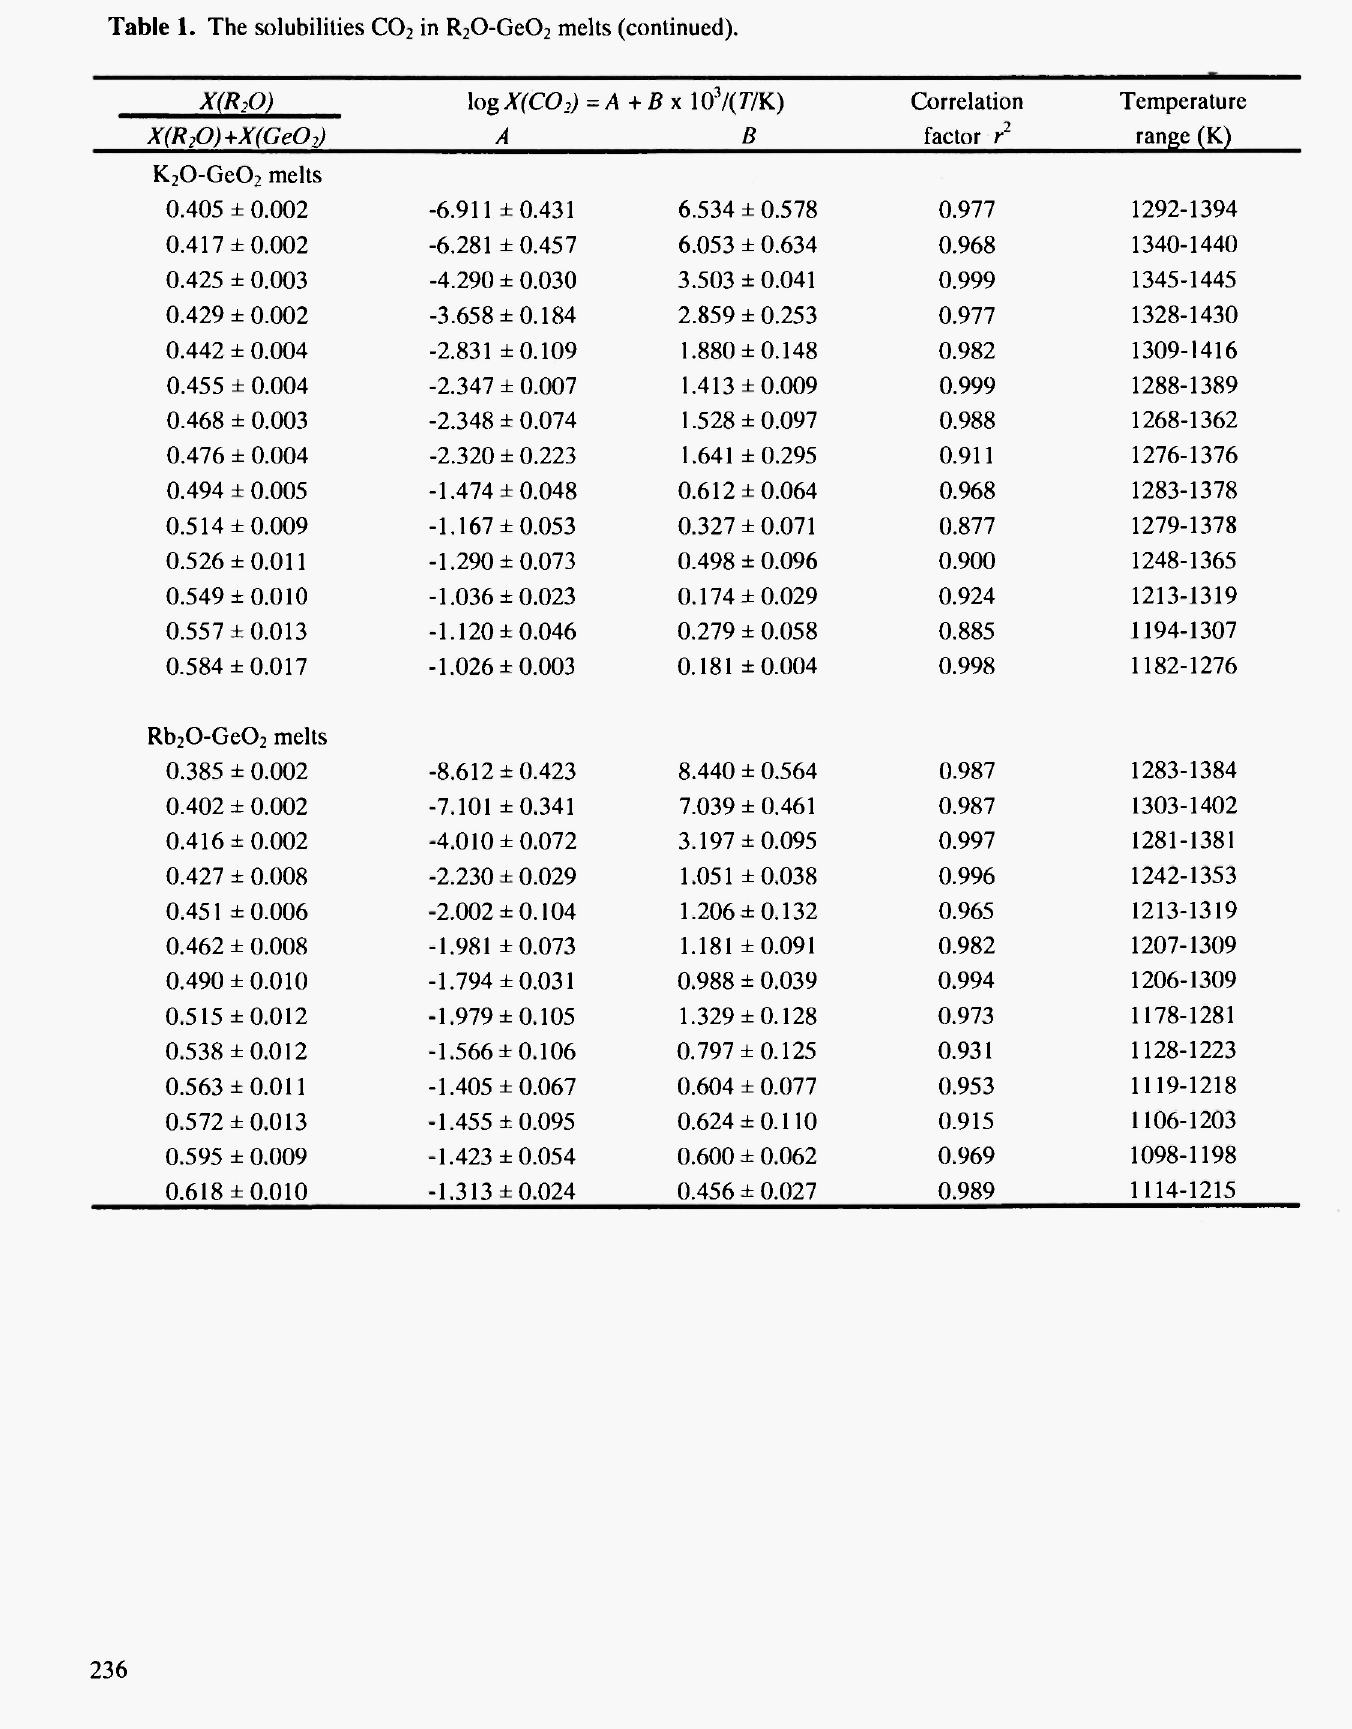
Table 1. The solubilities C0 2 in R 2 0-Ge0 2 melts